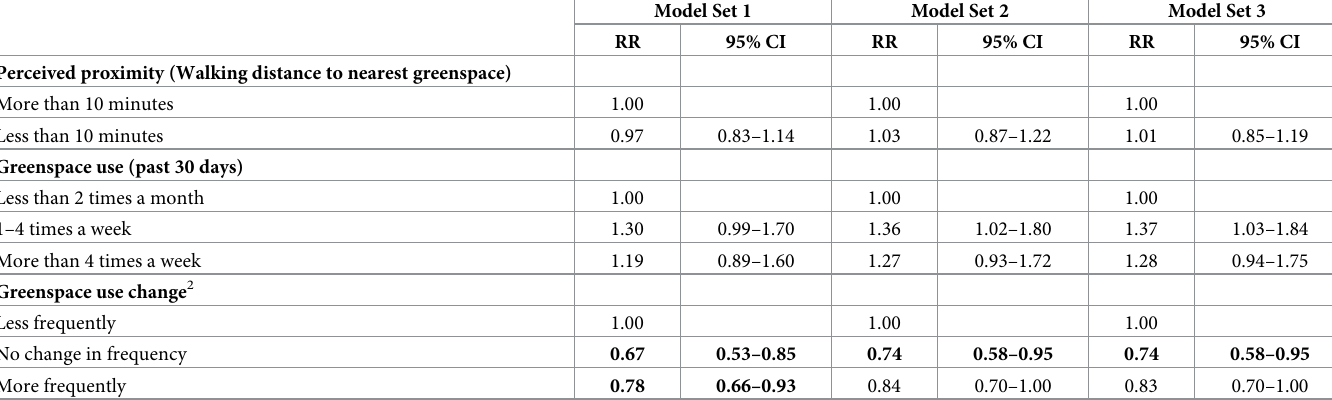
Table 3. Estimates of association between the greenspace measures and worsened mental health, comparing the survey period to before the start of pandemic- related social distancing measures in March of 2020 1 .